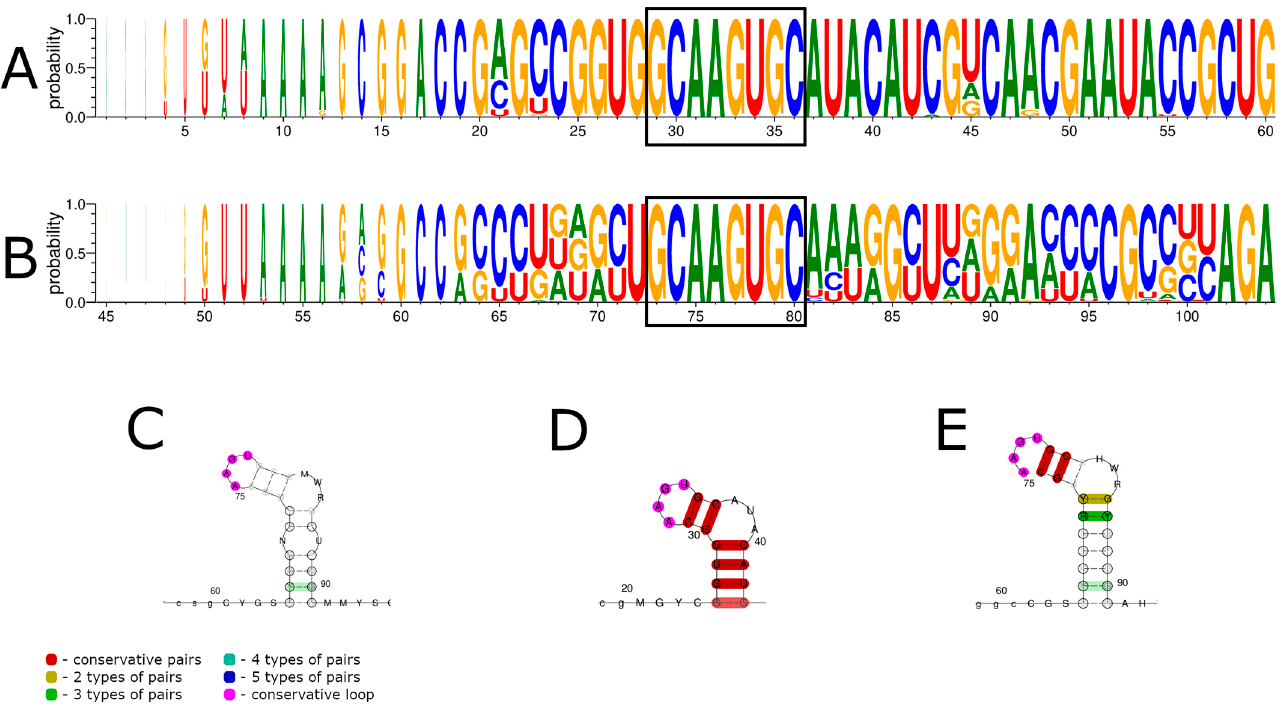
Figure 2. Consensus sequences and structures of JMTV 5 ′ UTRs predicted by LocARNA. ( A ) Consensus sequences of JMTV segment two 5 ′ UTRs. ( B ) Consensus sequences of JMTV 5 ′ UTR segments one, three, and four. ( C ) Consensus structures of all segments of JMTV 5 ′ UTRs. ( D ) Consensus structures of JMTV segment two 5 ′ UTRs. ( E ) Consensus structures of JMTV 5 ′ UTR segments one, three, and four. Conserved nucleotides in the consensus sequence are marked by black boxes. Nucleotide enumeration in fi gures ( C – E ) follows the enumeration in the alignment ( A ).